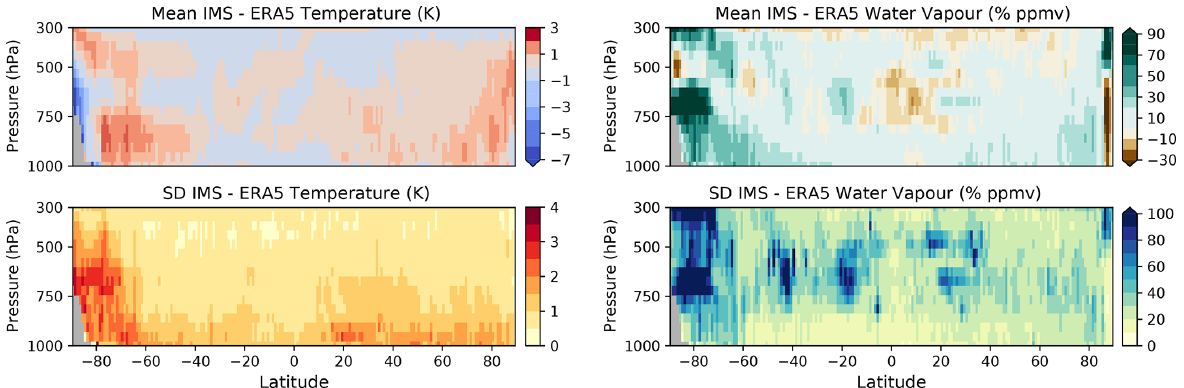
Figure 1. Example of the global mean differences between IMS temperature and water vapour profiles and ERA5 reanalysis for 15 June 2012. Also included are the standard deviations (SD) for the differences. Reanalysis has been interpolated to the observation time and the centre of the IASI instantaneous field view. Before differences were calculated, the IMS averaging kernels were applied to the reanalysis profiles. Both IMS and ERA5 use IASI data. Therefore, differences are partly due to the differing backgrounds (a priori) and the different information extracted from the satellite radiances. For further discussion on averaging kernels refer to Sect. 3